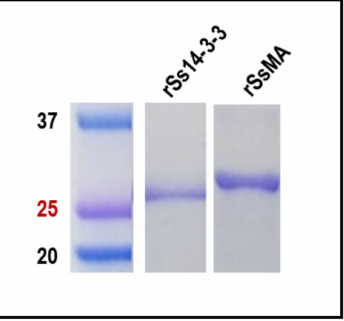
Figure 1. Synthesis and purification of rSs14-3-3 and rSsMA in E. coli. Purified recombinant Ss14-3-3 and SsMA proteins (10 µ g/lane) were separated on SDS-PAGE and visualized using Coomassie blue stain. Molecular weight markers in kDa are shown (Precision Plus Protein TM Dual Color Standards (BIO-RAD, Hercules, CA,